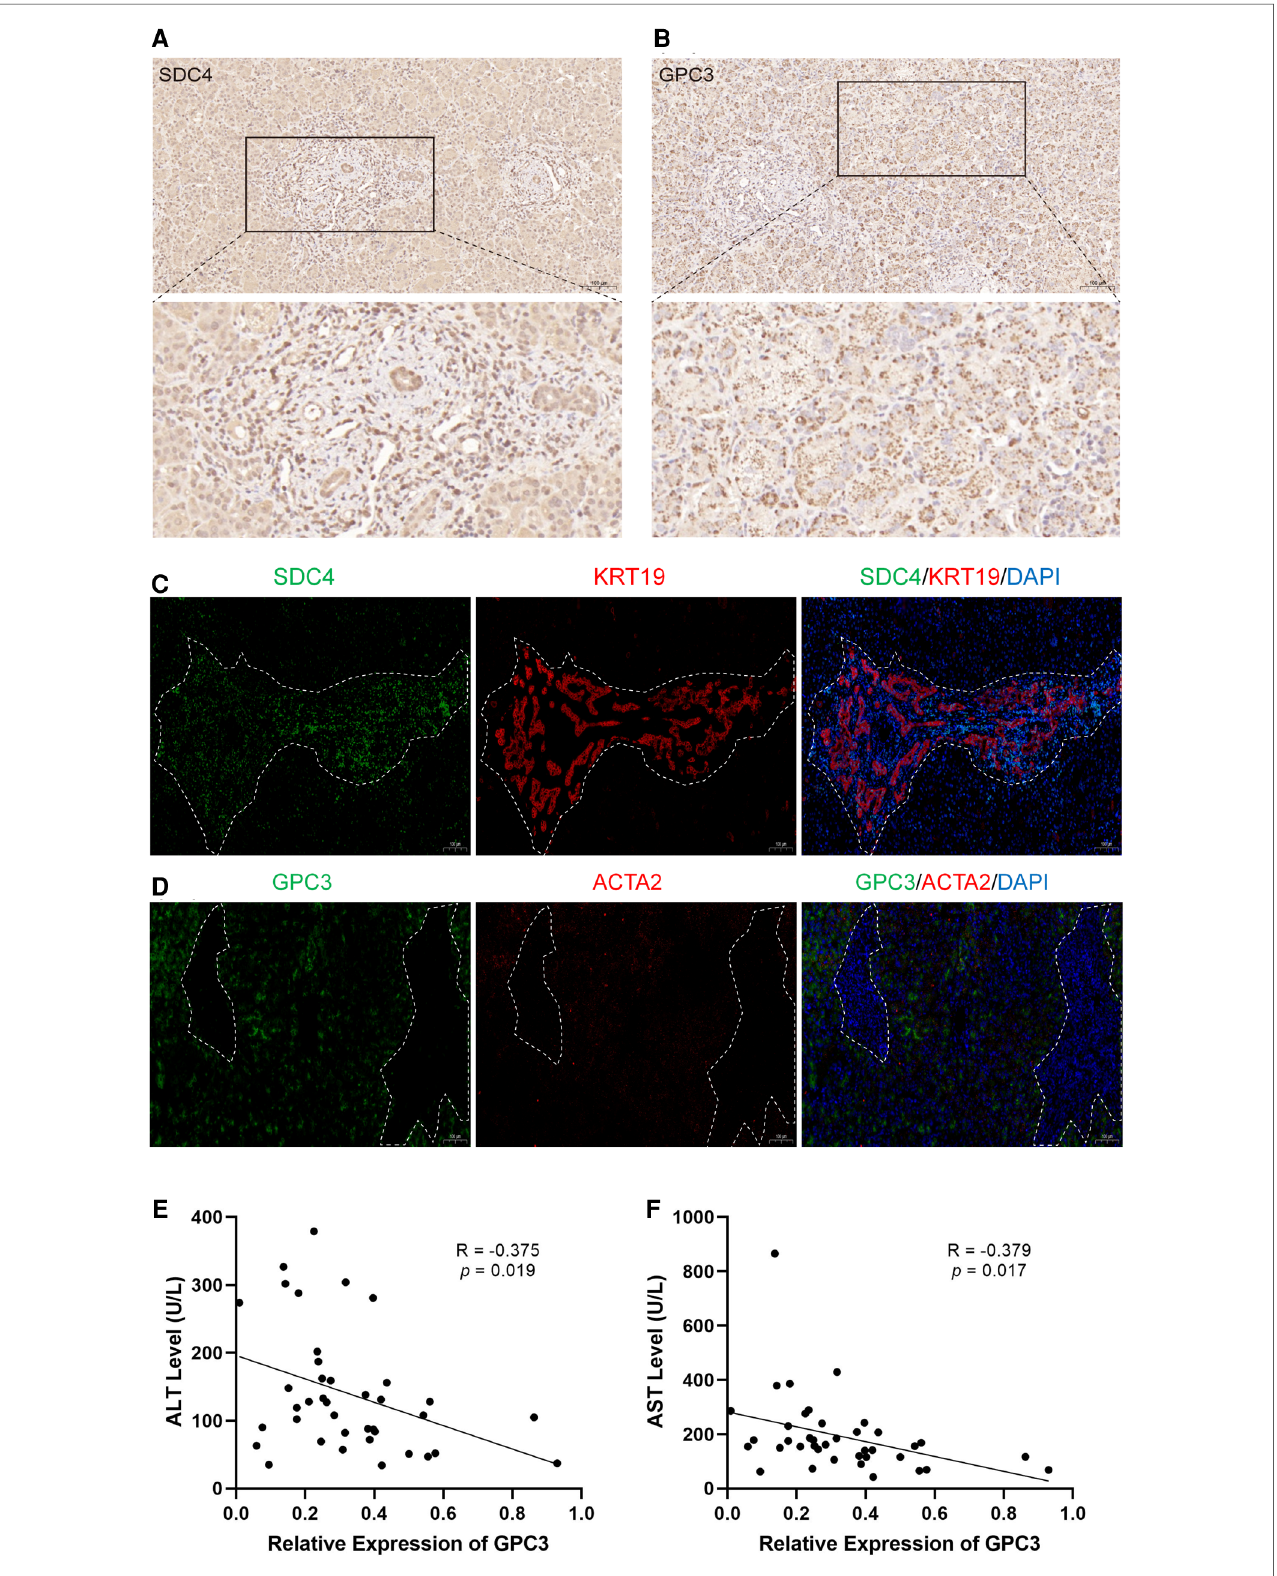
FIGURE 7 The expression of SDC4 and GPC3 with liver fi brosis and ductular reaction markers in BA liver tissues. Immunohistochemical staining of SDC4 ( A ) and GPC3 ( B ) in BA liver. Immuno fl uorescence of SDC4 and KRT19 ( C ), GPC3 and ACTA2 ( D ) in BA liver. The white dotted line marks out the extent of portal area. The correlation of relative expression of GPC3 with ALT ( E ) and AST ( F ). BA, biliary atresia; ALT, alanine aminotransferase; AST, aspartate